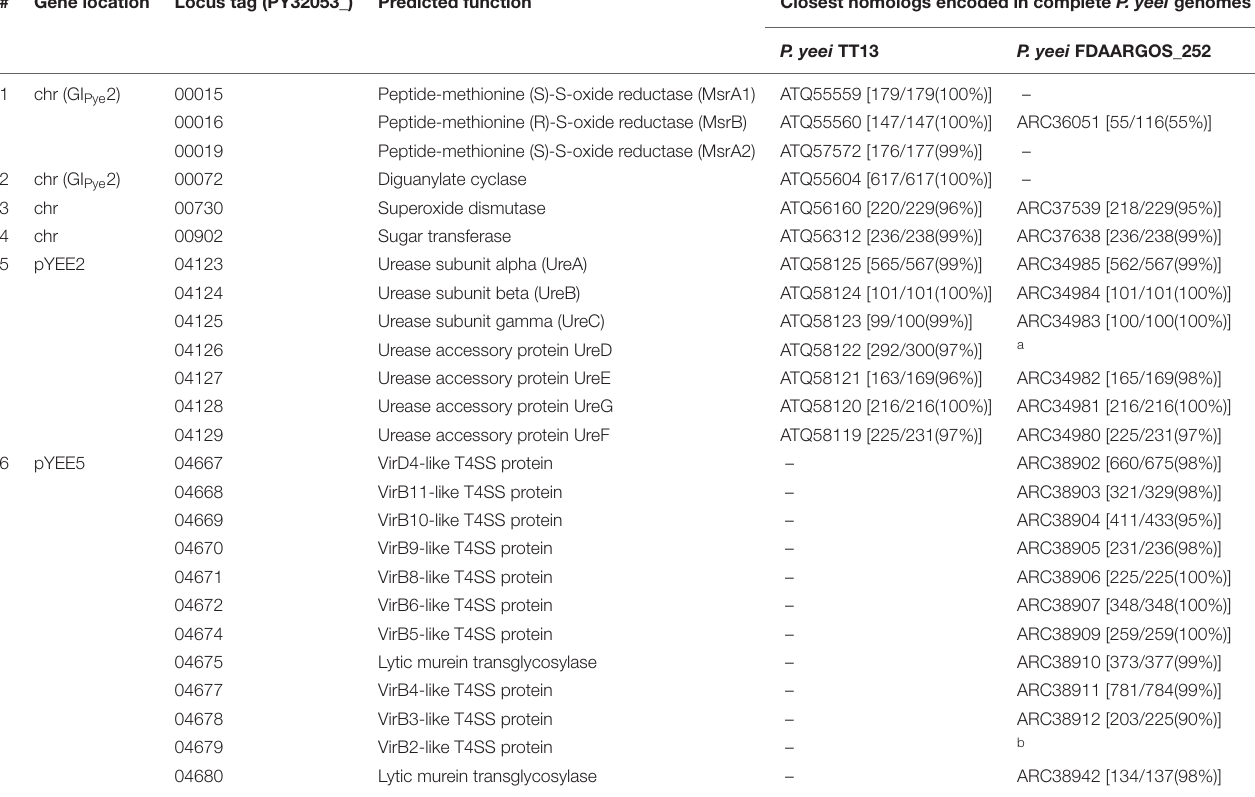
TABLE 2 | Putative virulence determinants of P. yeei CCUG 32053. # Gene location Locus tag (PY32053_) Predicted function Closest homologs encoded in complete P. yeei